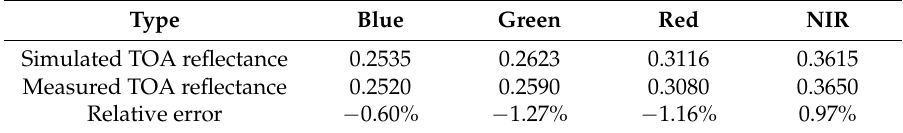
Table 8. Relative error between simulated TOA reflectance calculated by BRDF and measured TOA reflectance calculated by official calibration coefficients.